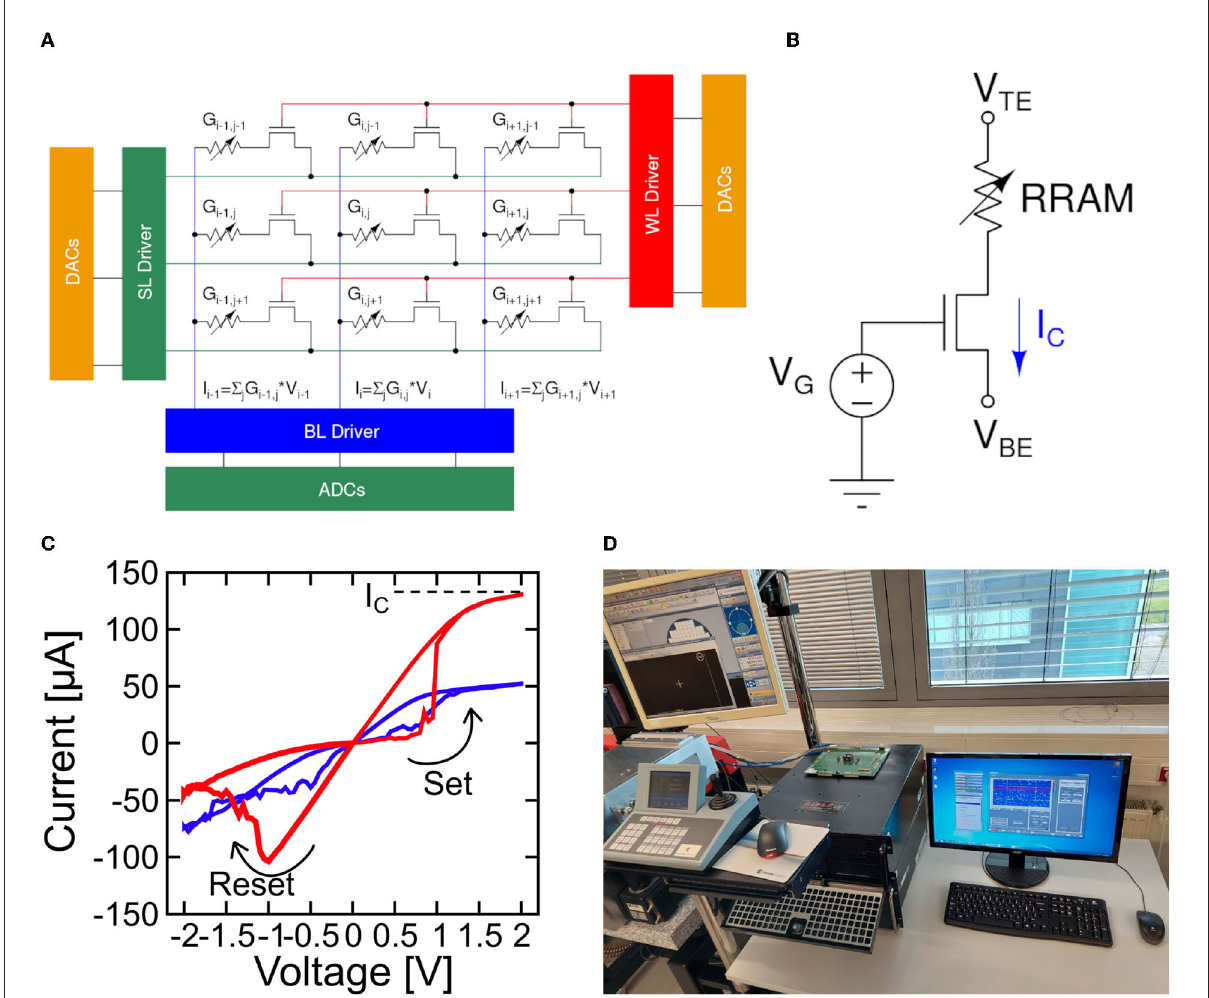
FIGURE2 (A) Crossbar array architecture for matrix-vector-multiplication (MVM) operations. (B) Schematic of a 1T1R resistive switching memory (RRAM) device integrated into the 4 kbits array used in this work. (C) I–V characteristics of a 1T1R RRAM device measured for increasing V G